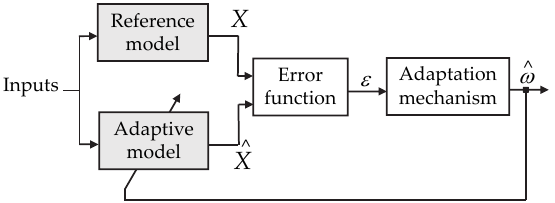
Figure 20. General illustration of a speed estimator based on